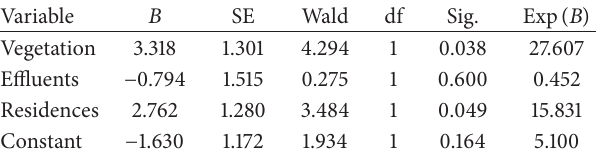
Table 4: Parameter estimates, standard errors, Wald test, degrees of freedom, and descriptive level for the final logistic regression model adjusted between the species richness and environmental variables (vegetation, effluents, and residences) on the intertidal zone of the Amazon River at Macap´a, Amap´a